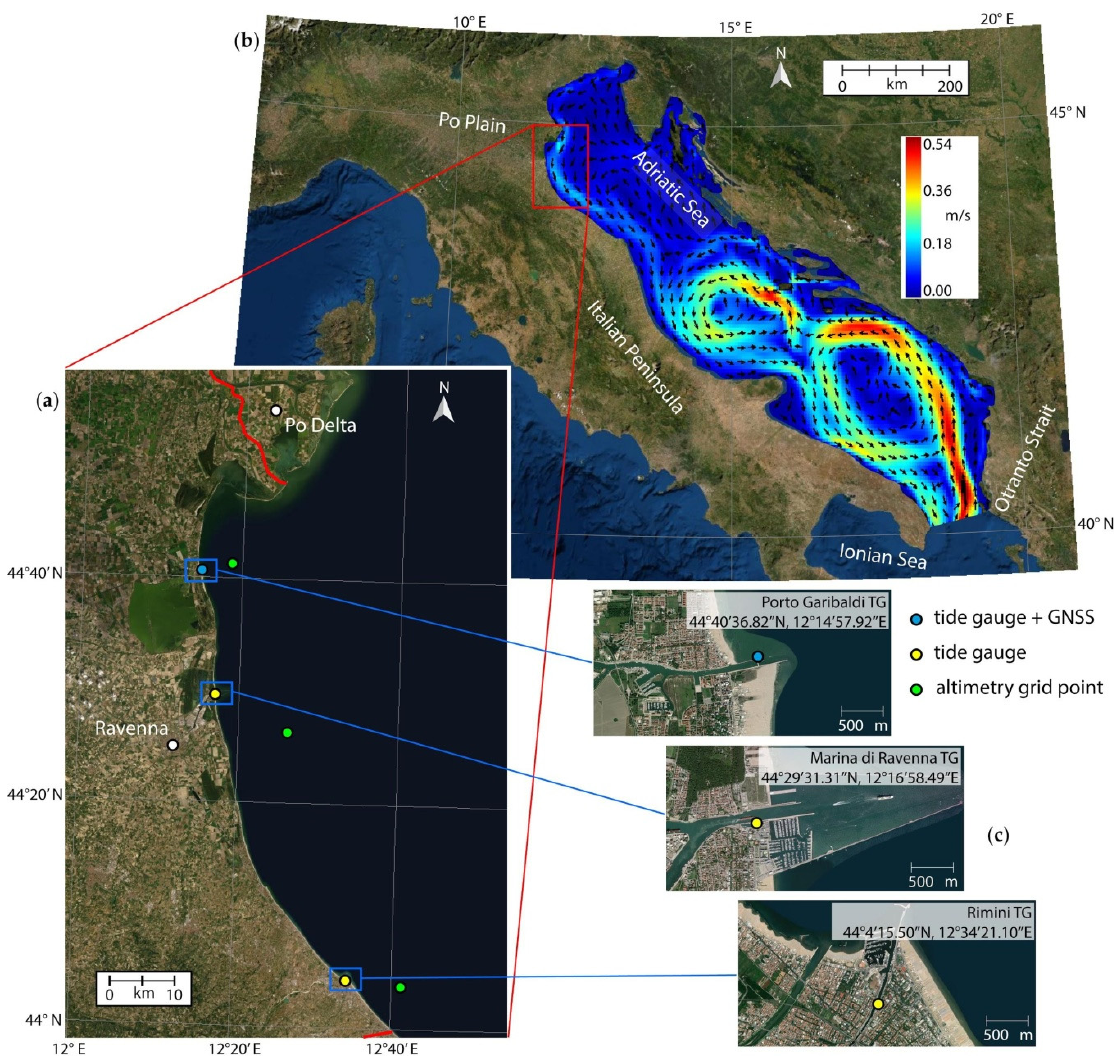
Figure 1. Satellite overview of the study site. ( a ) The E-R coast with northern and southern limits marked by red lines, the location of the selected tide gauges (blue and yellow circles) and their nearest satellite altimetry grid points (green circles). The blue circle at Porto Garibaldi remarks that, differently from the other two, the TG site is co-located with a GNSS antenna. ( b ) map of the surficial (upper 10 m layer) Adriatic current directions and velocity vectors (November 2018 monthly average, based on the MEDSEA_REANALYSIS_PHYS_006_004 model) [49]. ( c ) Detailed location of the three tide gauges considered in this work.